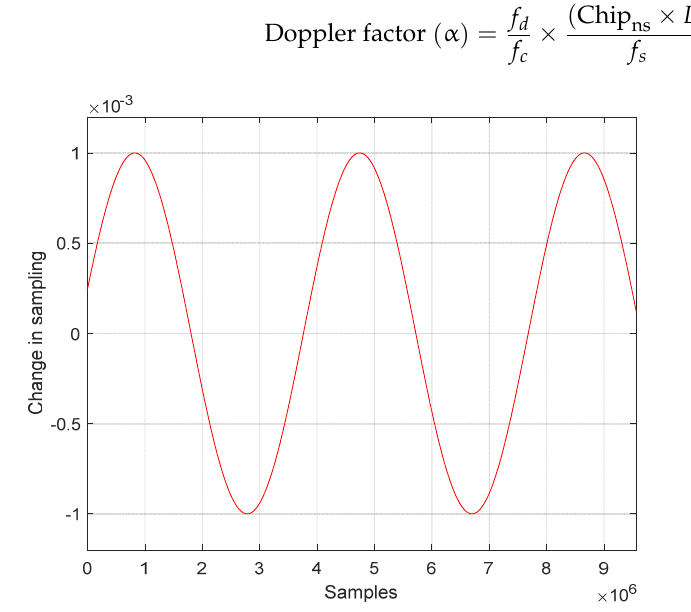
Figure 8. Change of sampling frequency in time domain.